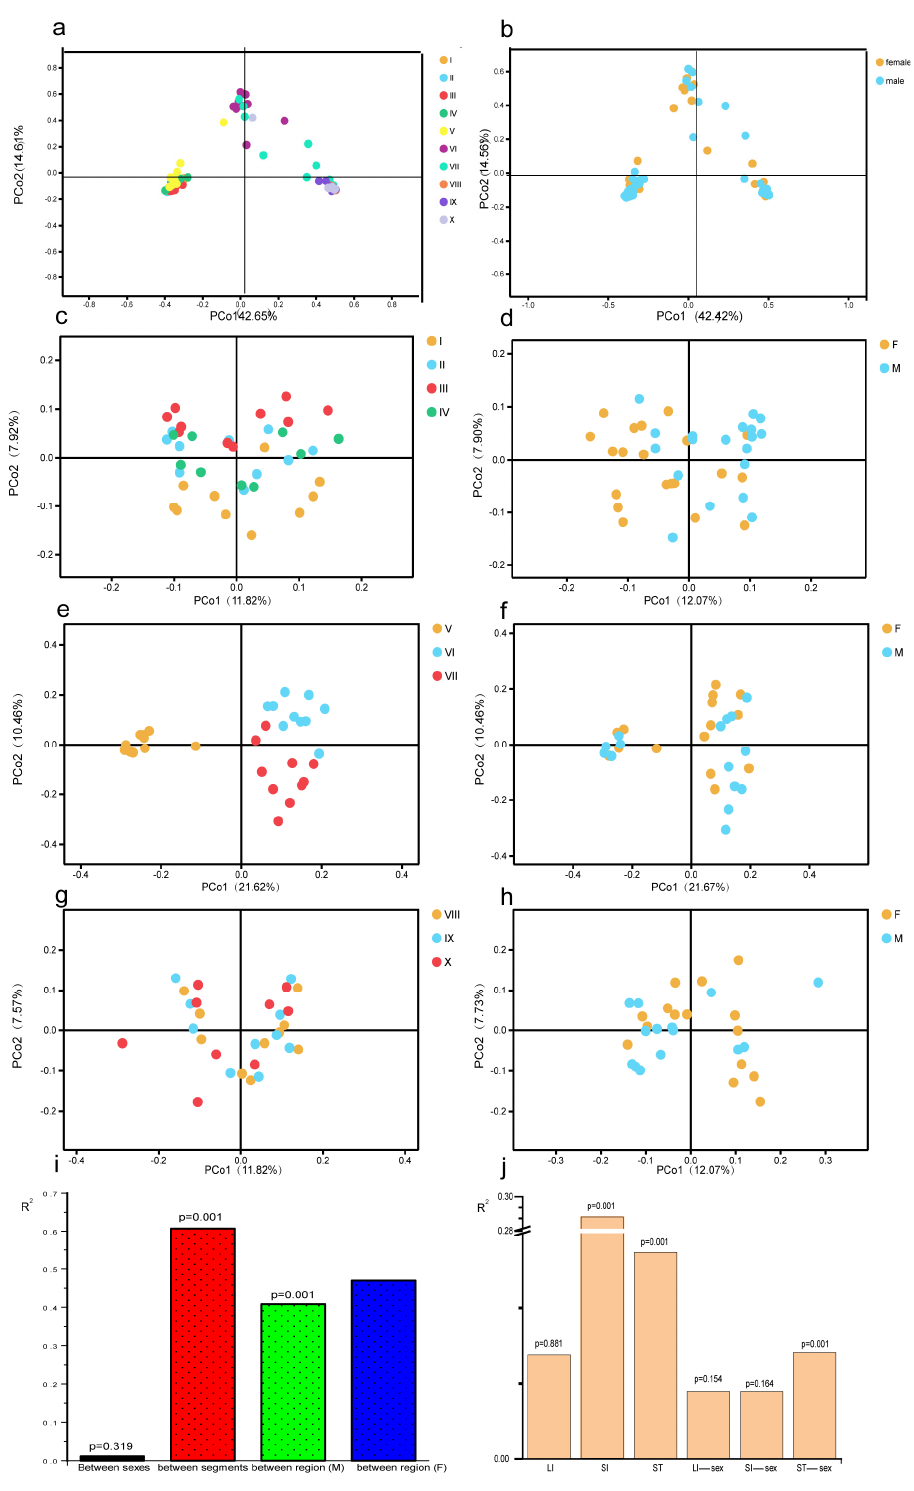
Figure 2. Plot combination illustrates the bacterial composition shift. PCoA plot ( a , b ) indicates that all samples are clustered by sections ( a ) and the sexes ( b ) based on Unweighted Unifrac distance. PCoA plot of each region in the GIT ( c – h ) based on unweighted Unifrac distance. ( c – d ) Samples from 4 sections of stomach; ( e – f ) samples from 3 sections of small intestine; ( g – h ) samples from 3 sections of large intestine. Bar plots ( i , j ) show the Permanova analysis results based on unweighted Unifrac distance, ( i ) plot showing the R2 value of all samples by sections or by sex; ( j ) the R2 value by sections or the sexes in each region, LI is the abbreviation for large intestine, SI is the abbreviation for small intestine and ST is the abbreviation for stomach. The R 2 value is used to assess the extent of discrepancy between sections or the sexes. The p -value above each bar means difference significance, p < 0.05 means significantly